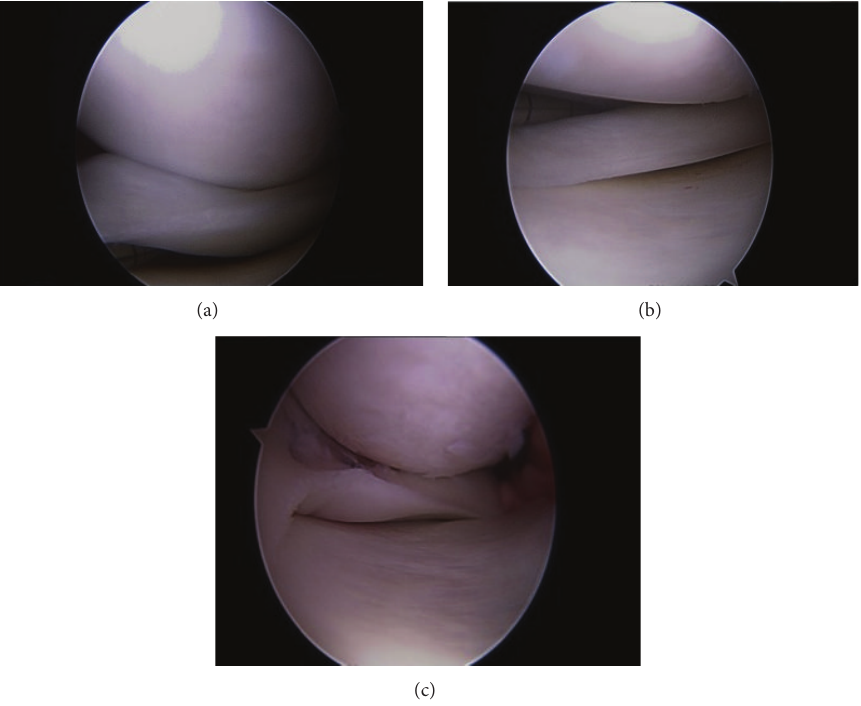
Figure 2: (a) Unusually large posterior horn suggesting partial discoid medial meniscus. (b) Probe inserted into the intrasubstance degeneration via the superior surface tear. (c) Medial meniscus after repair of peripheral fragment.